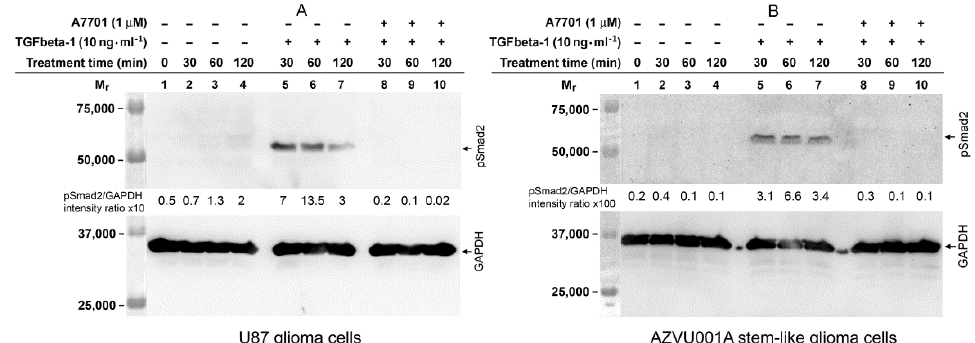
Figure 8. Western blot analysis of TGFbeta-1-induced phosphorylation of Smad2 protein in glioma cells. ( A ) U87 glioma cells and ( B ) AZVU001A glioma stem-like cells treated with recombinant TGFbeta-1 for the indicated times showed the presence of phosphorylated Smad2 (pSmad2) protein (lanes 5, 6, and 7, upper immunoblots). pSmad2 was undetectable in U87 glioma cells and in AZVU001A glioma stem-like cells cultured in the absence of TGFbeta-1 (lanes 2, 3, and 4, upper immunoblots) or in the presence of both TGFbeta-1 and TGFbeta type I receptor inhibitor A7701 (lanes 8, 9, and 10, upper immunoblots). The lower immunoblots show immunodetection of GAPDH which served as a protein loading